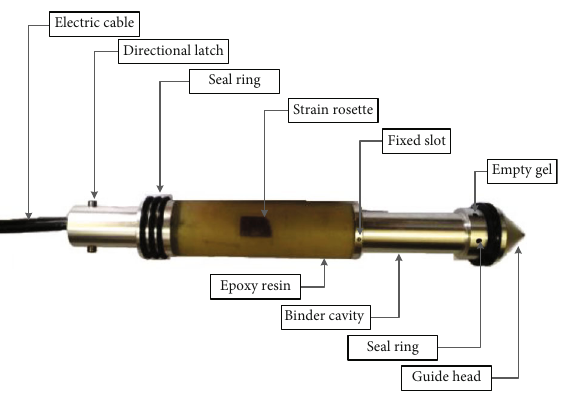
Figure 3: Structural diagram of